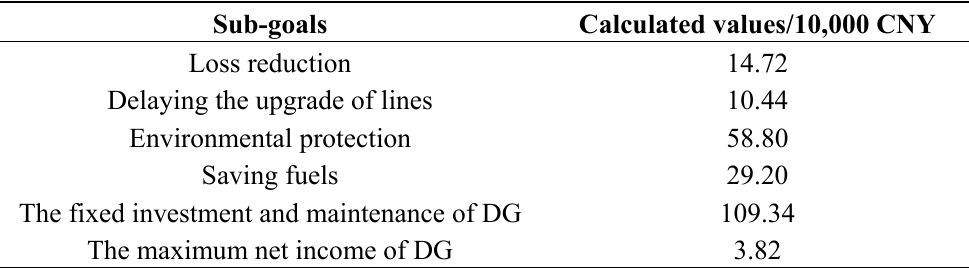
Table 4. The calculated values of each